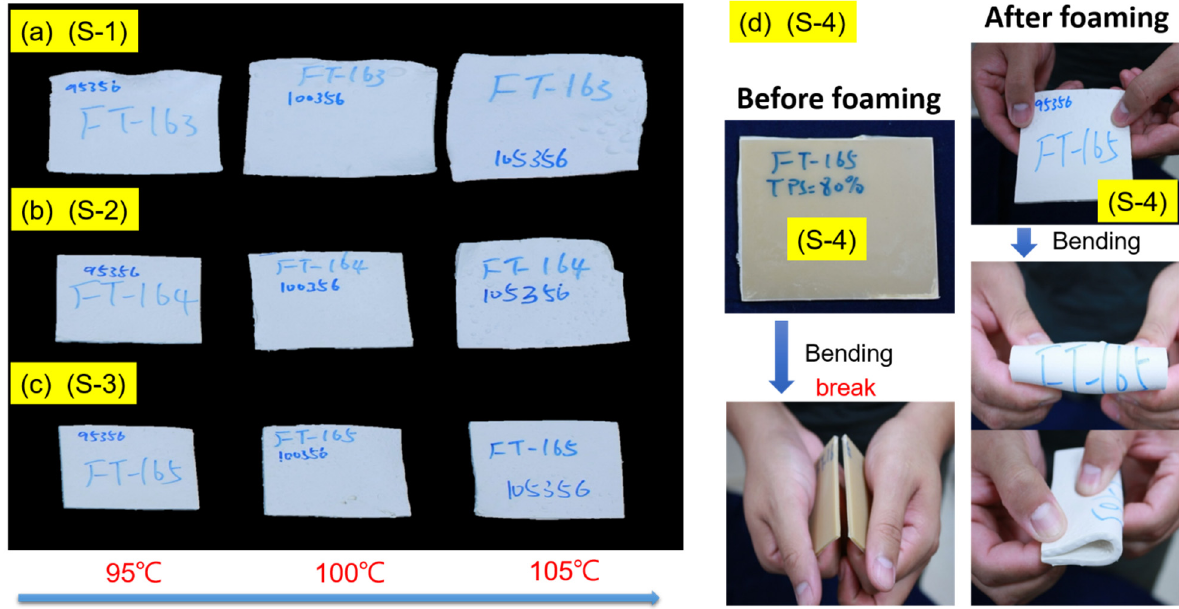
Figure 6. The appearance of foams with different ratios (SA/TPS) and PBAT composite ( a ) [S-1], ( b ) [S-2], and ( c ) [S-3] at three foaming temperatures and a foaming pressure of 23.8 MPa impregnated with CO 2 . ( d ) Comparing the foam appearance characteristics and flexural limitations of the [S-4] before and after.